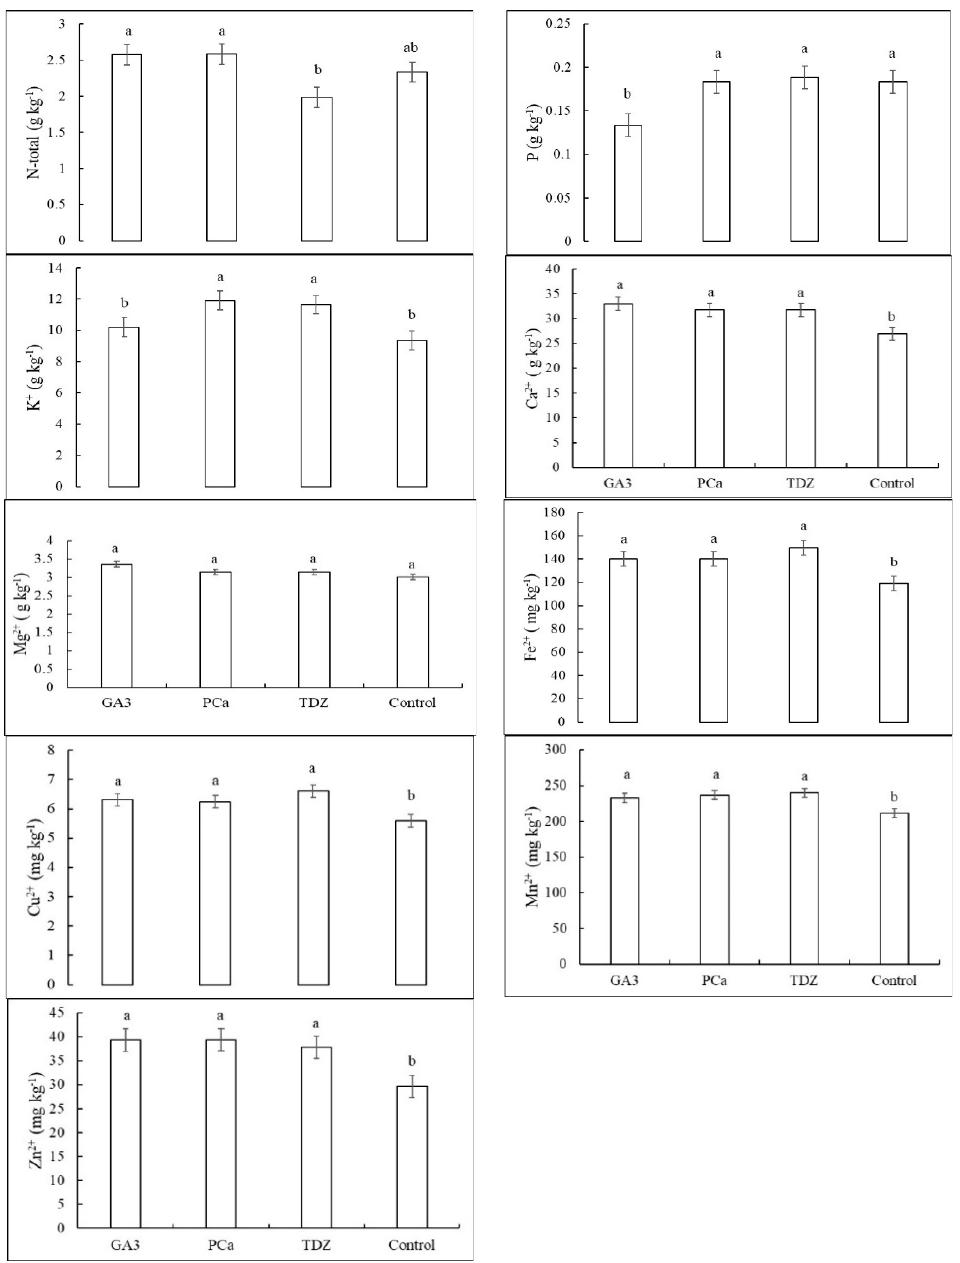
Figure 2. Concentrations of nutrients in pecan trees cv. Wichita after applying foliar growth regulator treatments. The results are the means per treatment over two seasons (2017 and 2018). GA 3 : gibberellic acid (50 mg L − 1 ); PCa: prohexadione calcium (500 mg L − 1 ) and TDZ: thidiazuron (10 mg L − 1 ) and a water control. Bars with the same letter are not significantly different based on Tukey’s test ( p ≤ 0.05). Error bars represent standard deviations ( n = 5).